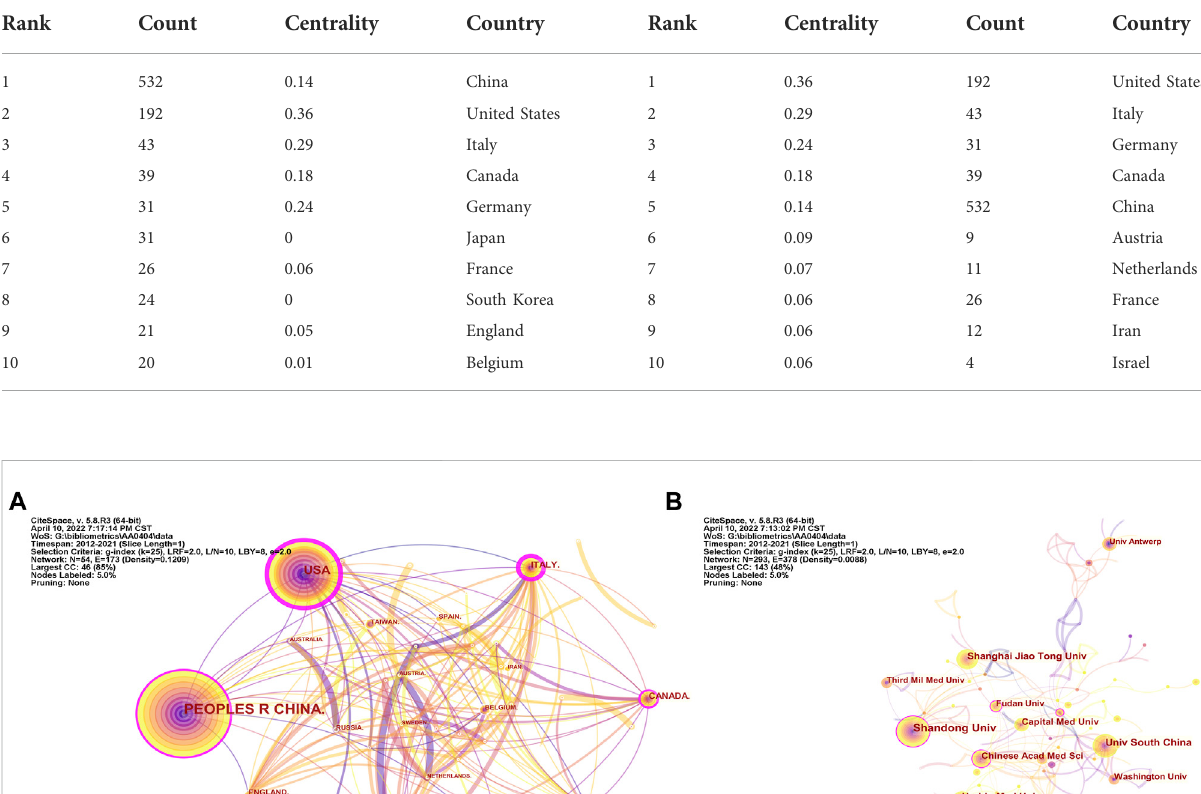
TABLE 1 Top 10 countries in terms of publications and centrality.